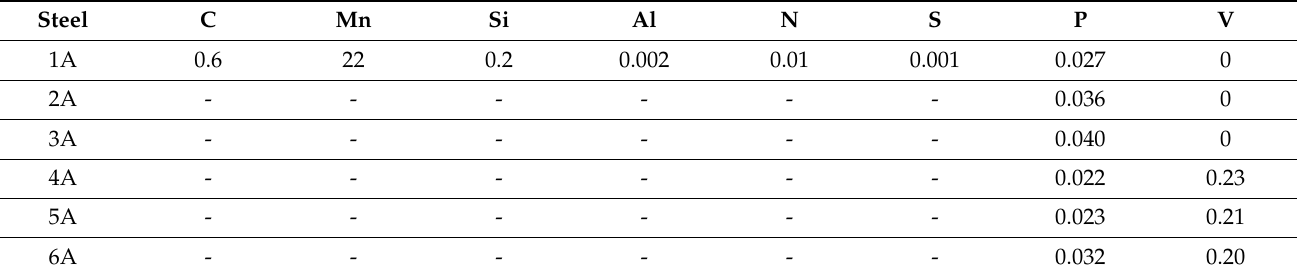
Table 1. The composition of the steels examined, in